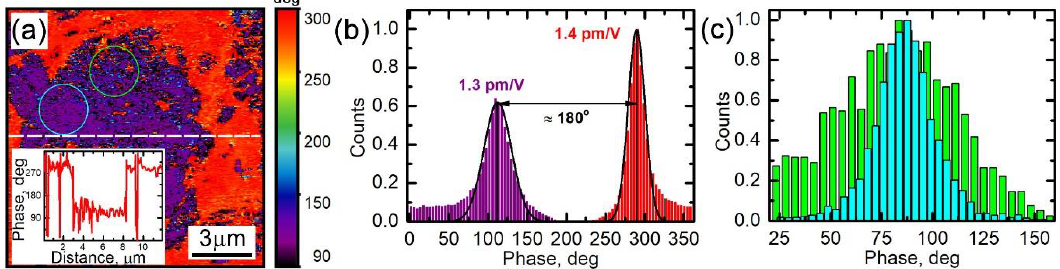
Figure 4. Analysis of the LF ESM signal phase in the active ionic particle. ( a ) LF ESM phase; the inset shows the line profile of the image along the dashed line. ( b ) Histogram of the image in panel ( a ); average EM response amplitudes corresponding to the histogram peaks are indicated near the peaks. ( c ) Local histograms for the signal in the image in ( a ) from the areas marked in ( a ) by the circles with corresponding colors.